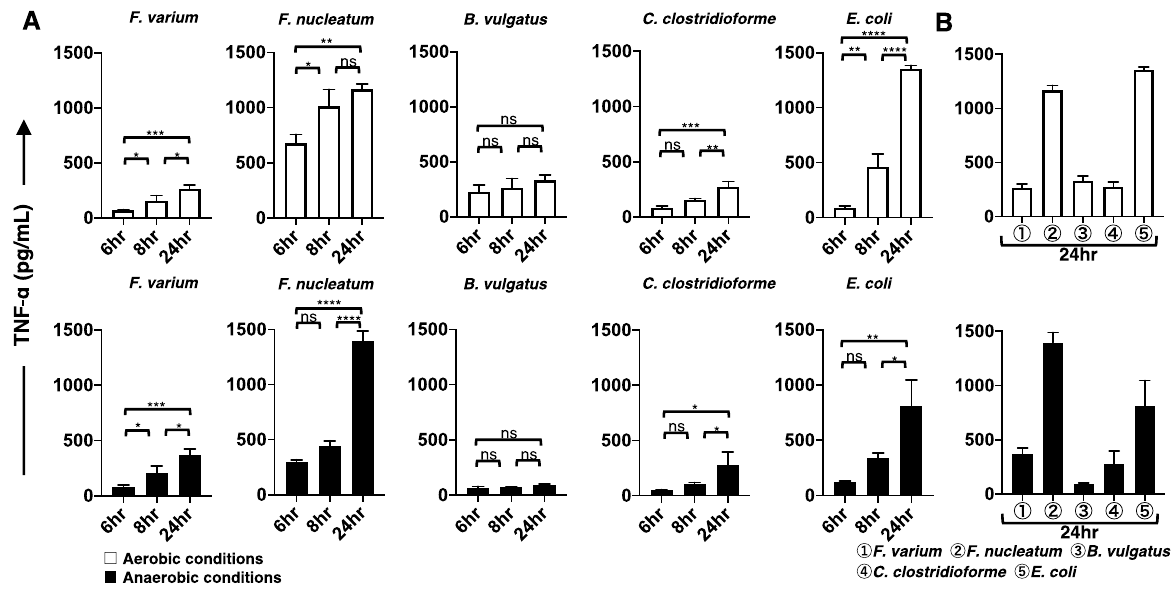
Figure 7. The production of TNF-α by the DC line stimulated with live commensal bacteria. ( A ) Under aerobic (upper panel, white bar) and anaerobic (lower panel, black bar) stimulation conditions, TNF-α production during the initial phase (total of 6 and 8 h) and late phase (total of 24 h) was assessed in the DC line after stimulation with six strains of live commensal bacteria. ( B ) Under aerobic (white bar) and anaerobic